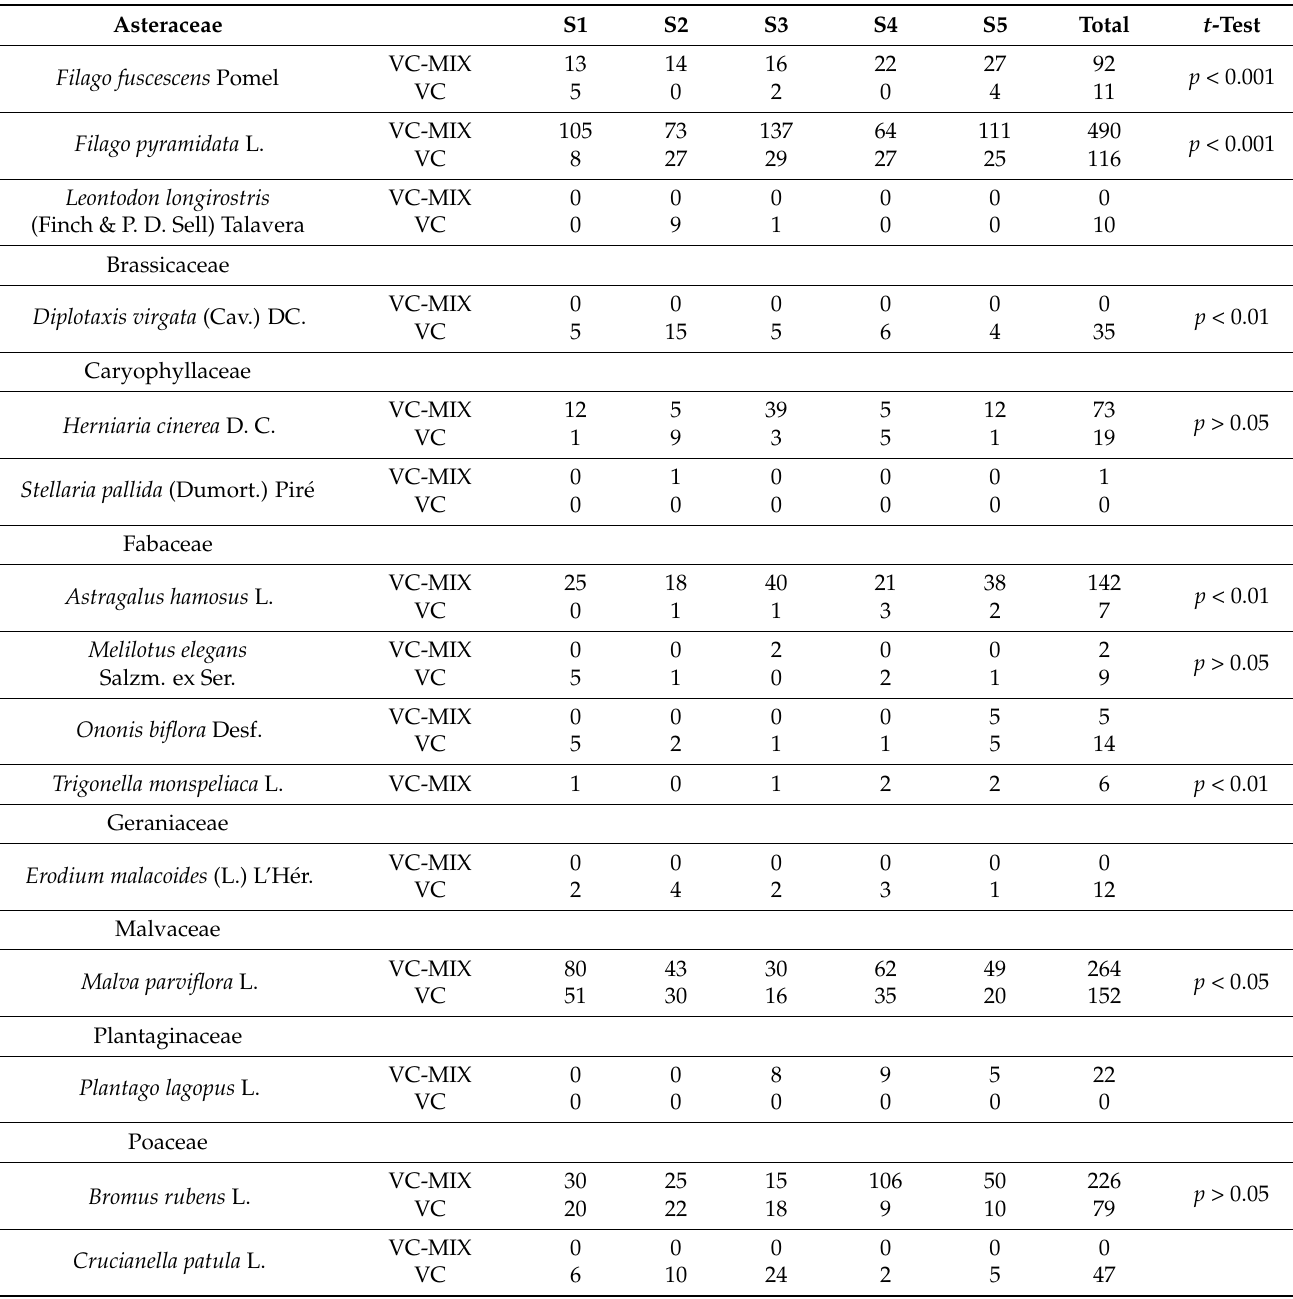
Table 1. List of species inventoried in VC and VC- MIX olive groves, and frequency indices in each sampling (S1–S5). The percentages of bare soil in both olive groves are indicated